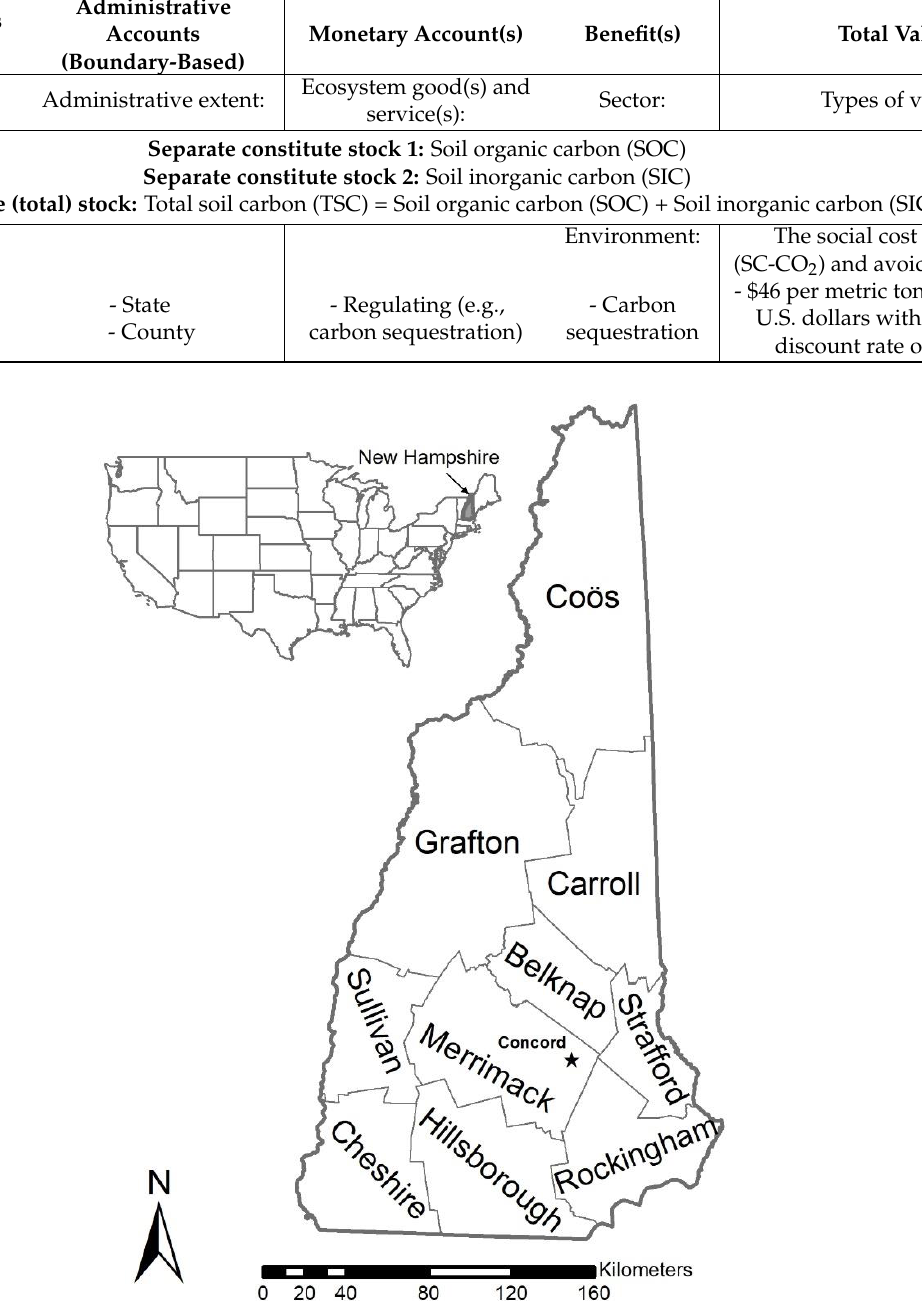
Figure 2. Administrative map of New Hampshire (U.S.A.) (Latitude: 42° 42′ N to 45° 18′ N ; Longi-